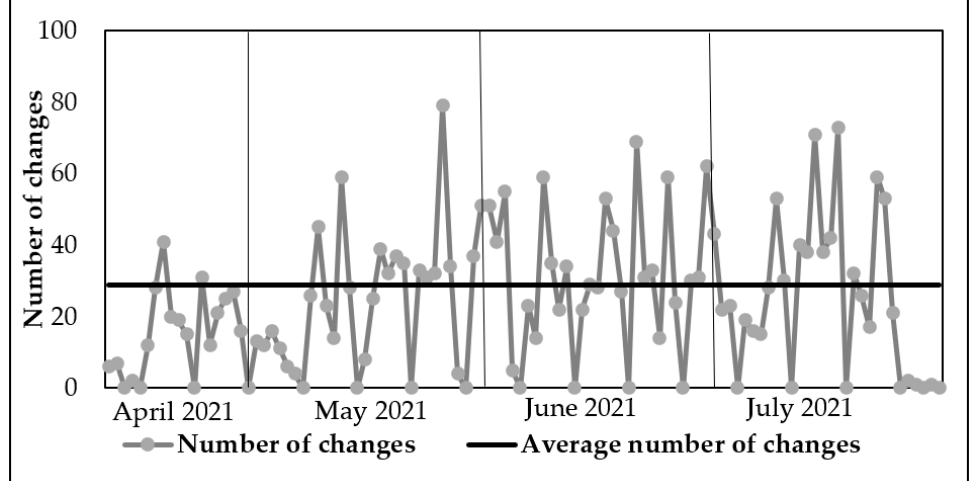
Figure 7. Number of changes in Variant 3 .